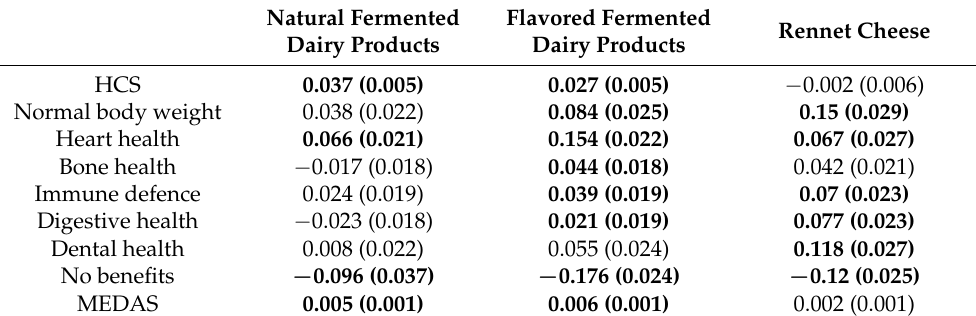
Table 4. Association of health concern scale, health beliefs and diet quality with consumption of fermented products according to their